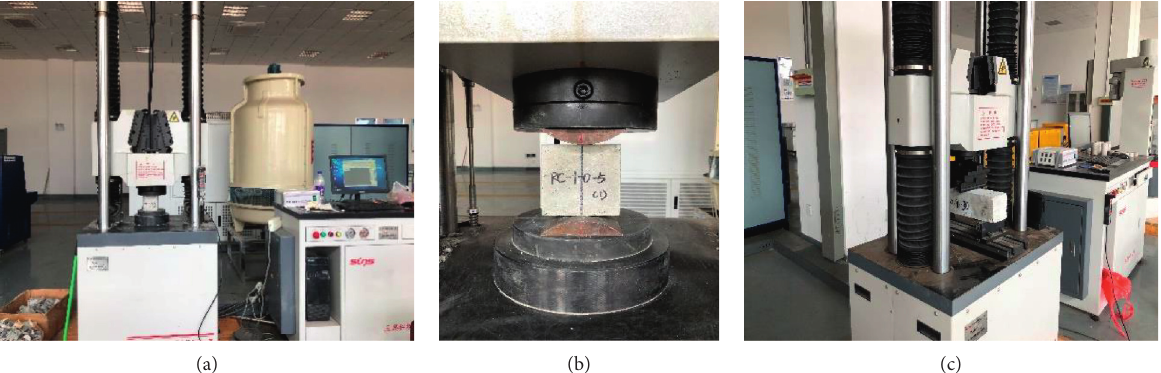
Figure 2: Basic static mechanical test. (a) Universal testing machine. (b) Splitting tensile fixture. (c) Four-point flexural tensile